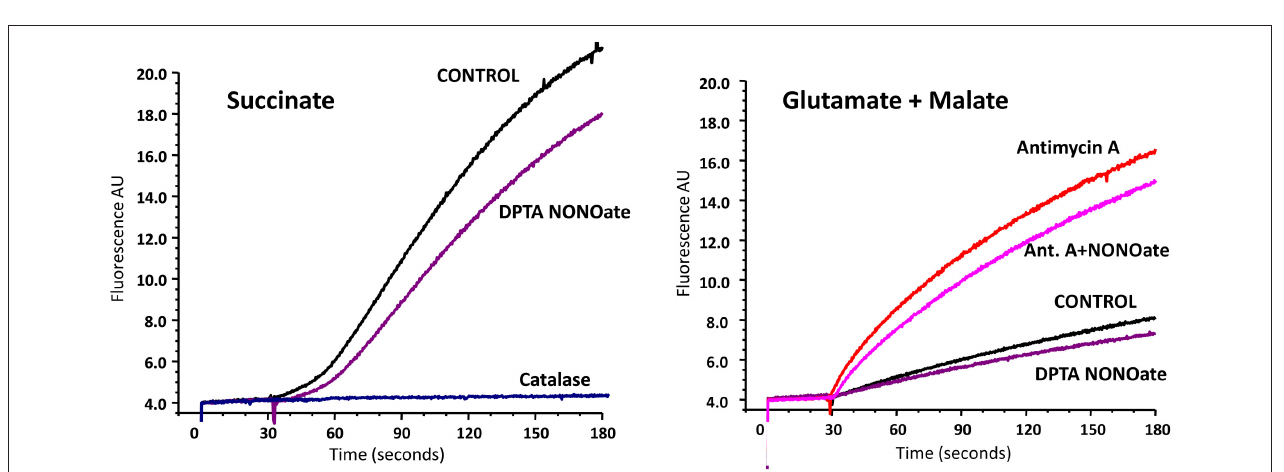
FIGURE 2 | Effect of nitric oxide on H 2 O 2 release by rat brain mitochondria measured with Amplex Red. Rat brain mitochondria (RBM) were supplemented with slow releasing NO-donor DPTA NONOate (100 µ M). To test the potential effect of NO on complex III-mediated H 2 O 2 production mitochondria were treated with complex III blocker Antimycin A (1 µ M). Release of mitochondrial H 2 O 2 was measured by Amplex Red assay as described in Material and Methods. Addition of catalase (20 µ g/ml) confirms specific detection of mitochondrial H 2 O 2 . Figure shows typical data of four independent